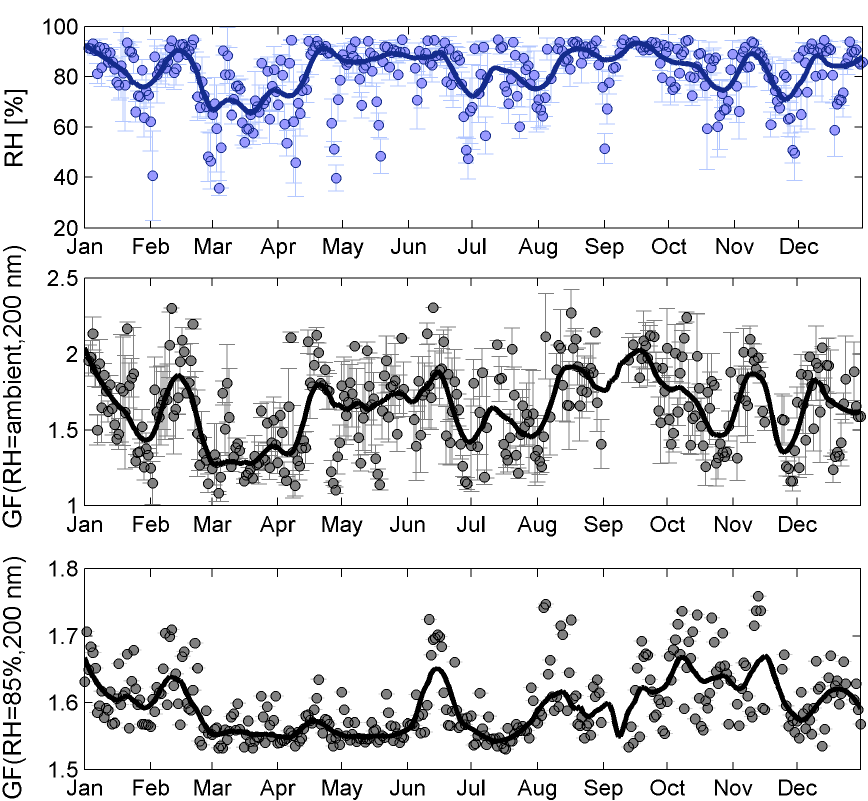
Figure 8. (a) Daily mean relative humidity (%) measured at the Zeppelin station for year 2008. (b) The calculated daily mean GFs assuming ambient RH for an initial size of 200nm. (c) The calculated daily mean GFs at RH = 85% for initial size of 200nm. In Fig. 9a and b the error bars indicate standard